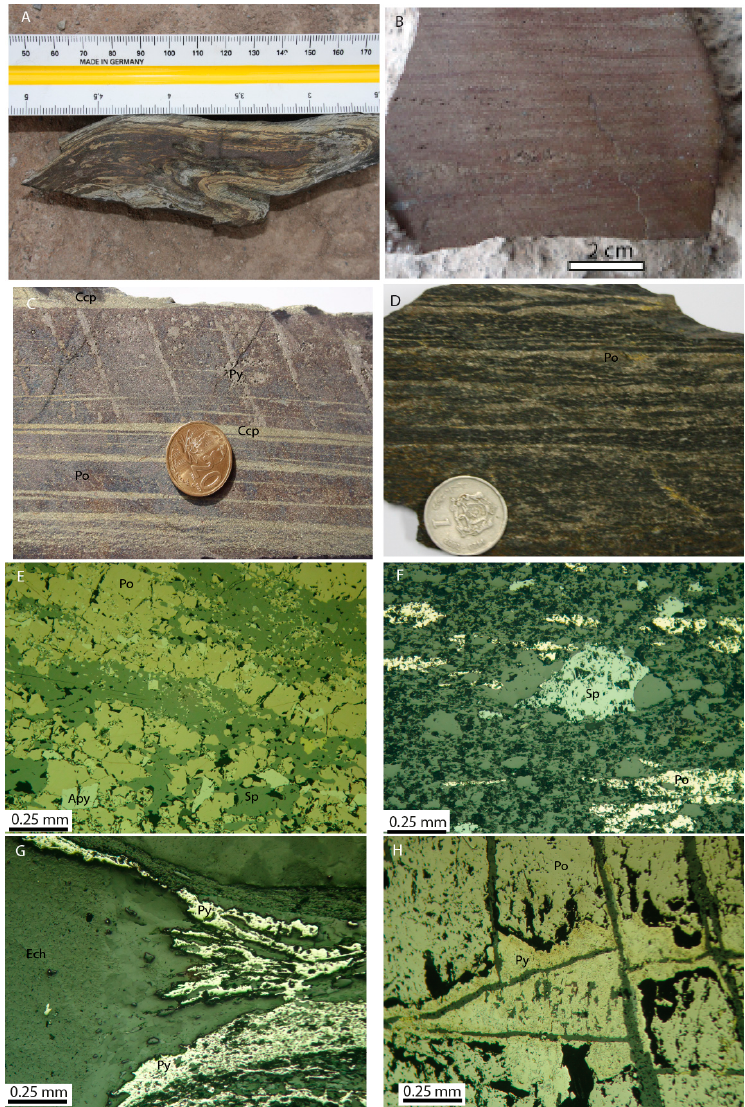
Figure 4. Representative photographs of some types and textural features of the Moroccan massive sulphide deposits (MMSD). ( A ) P 2 fold developed in a semi-massive pyrrhotite (Zn-rich lens of Tazakourt, Draa Sfar South deposit); ( B ) Faint layering marked by alternating sphalerite-rich and pyrrhotite-rich bands in the Zn-rich lens of Tazakourt; ( C ) Pyrite (Py) infilling cross-cutting and replacing pyrrhotite (Po); the pyrite veins are in turn replaced by chalcopyrite (Ccp) in parallel bands; ( D ) semi-massive ore with pyrrhotite-rich bands alternating with chlorite and sericite-rich bands. Rock located at the extremity of one Cu-rich lens of the Sidi M’barek orebody; photos (E–H) are microphotographs with plane polarised reflected light ( E ) Banded ore with sphalerite (Sp, grey)- and pyrrhotite (Po, pale yellow)-rich bands and disseminated arsenopyrite (Apy) grains (white) (crossed nichols); ( F ) Pyrrhotite (Po) grains elongated along the foliation plane showing pressure fringes around sphalerite (Sp) in a silicate-rich matrix (crossed nichols); ( G ) Pyrite (Py) in pressure shadows around Echinoderm (Ech) clasts (crossed nichols); and, ( H ) fractures infilled with carbonates and pyrite replacing pyrrhotite (crossed nichols).